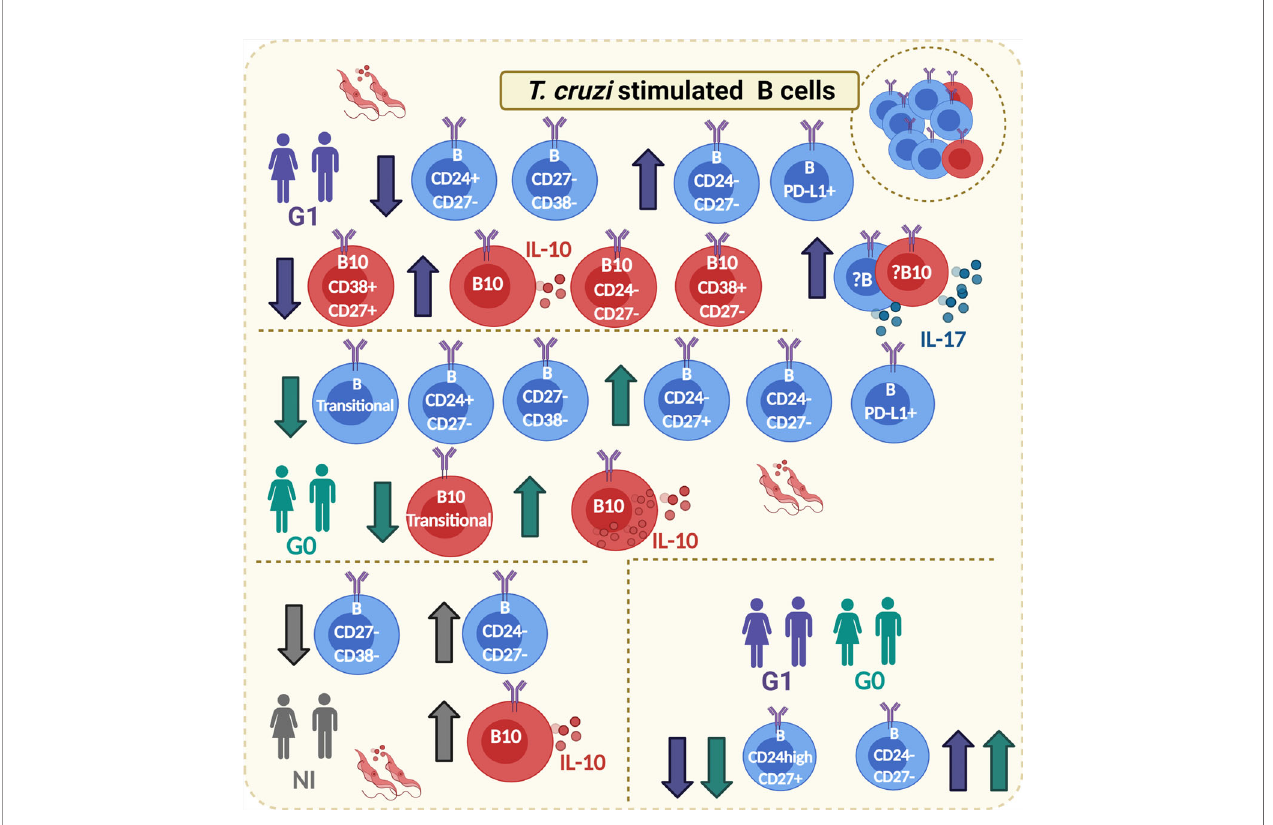
FIGURE 8 | Graphical abstract. Main phenotypic traits identi fi ed on B and B10 cells from CCD patients with or without cardiac manifestations and NI donors in response to T. cruzi stimulation. Boxes with T. cruzi parasite images in red show changes observed on T. cruzi – stimulated B cells, whereas the lower box on the right corresponds to changes on subpopulations of B cells that were independent of the stimulation condition. The direction of change is indicated with arrows (increase/decrease). The color of the arrows indicates in which groups of subjects was detected the mentioned alteration (green arrows: G0; purple arrows: G1; gray arrows: NI). Full circles in the cell cytoplasm indicate increased MFI for IL-10, while full circles outside the cell cytoplasm indicate increased secretion of the corresponding cytokine (IL-10 or IL-17). Created with